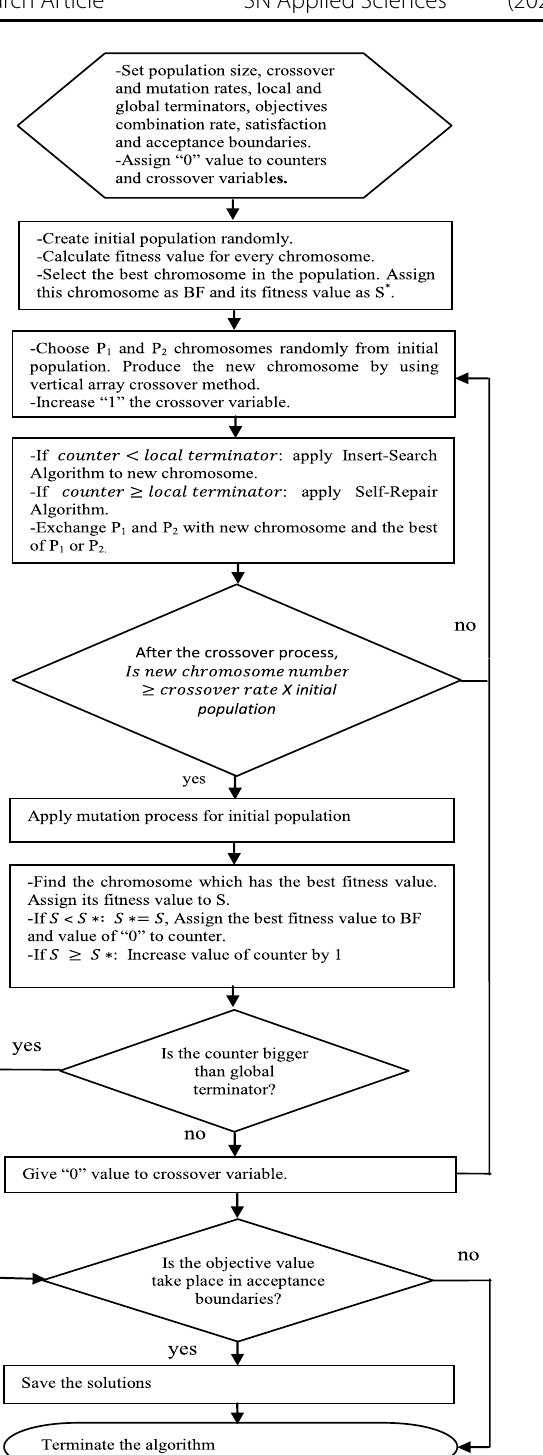
Fig. 1 Flow chart of proposed